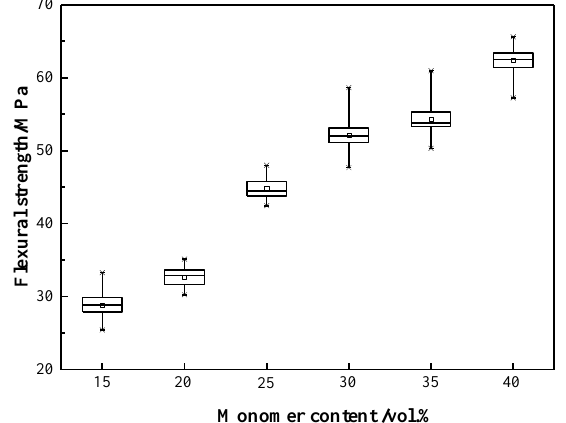
Figure 4. Effects of the solid loading on the rheological properties of the TiH 2 /Al slurries.